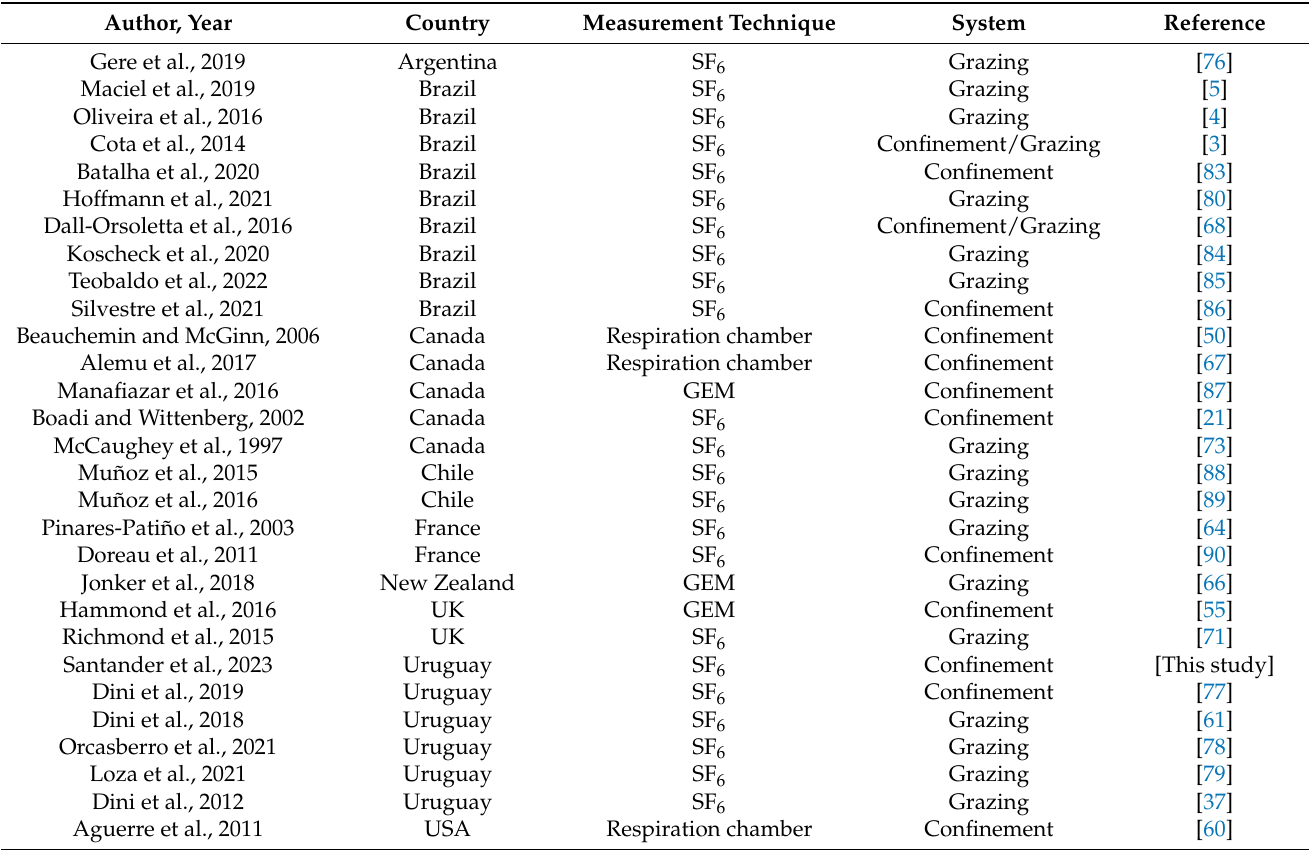
Table A1. Database of studies used for observed vs. predicted